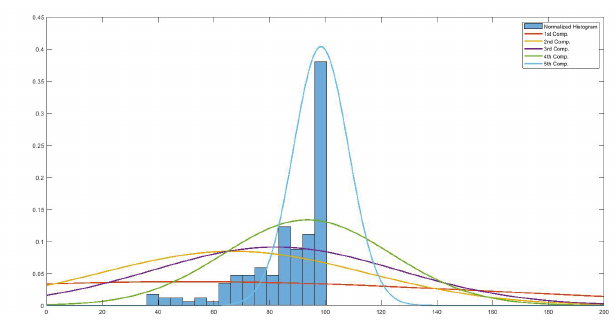
Figure 7. Prior conditional probability density functions of gaussian